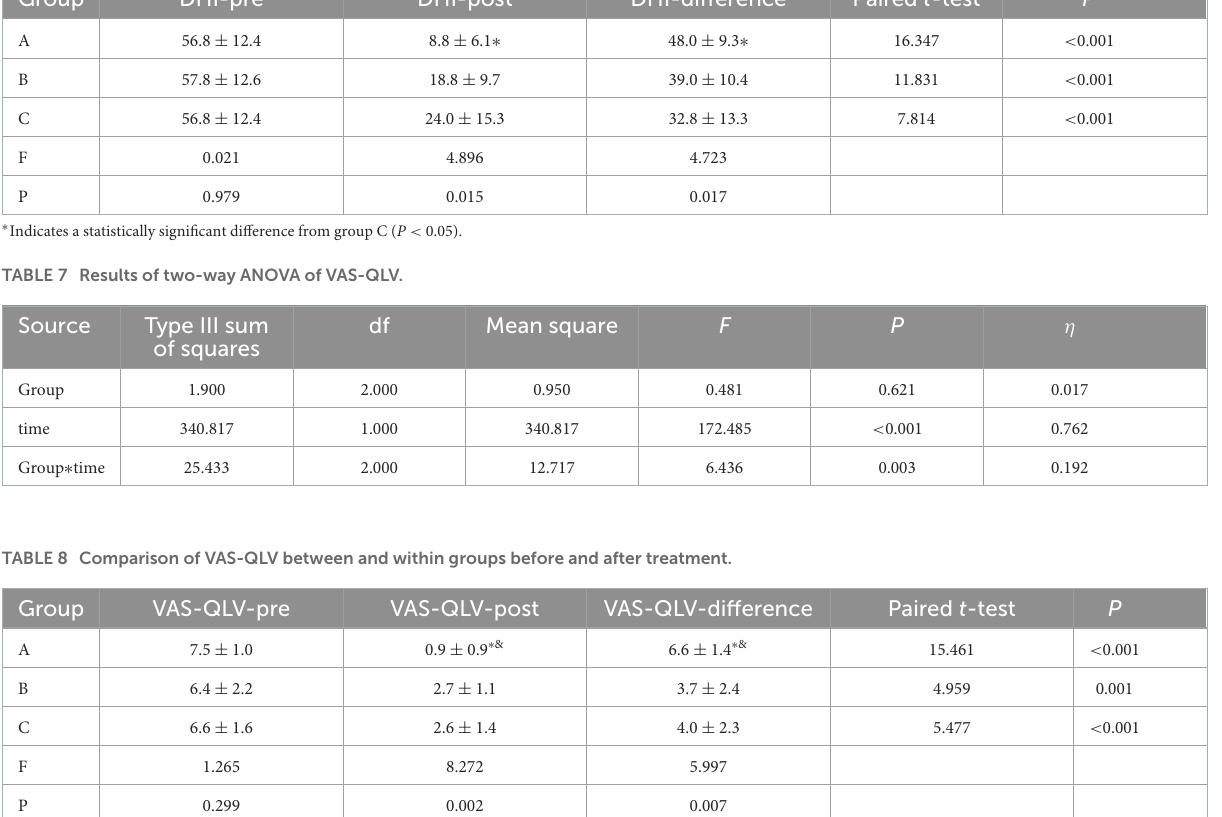
TABLE 6 Comparison of DHI between and within groups before and after treatment. Group